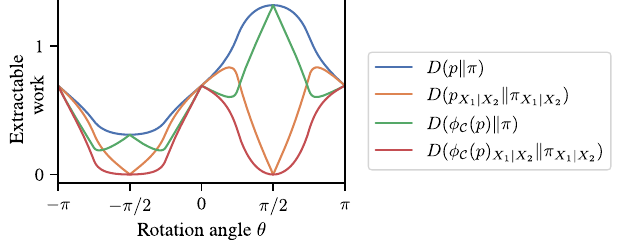
FIG. 14. Szilard box with gravity: bounds on extractable work as a function of θ , as derived from the second law [in blue, Eq. (98)], coarse-grained constraints [in orange, Eq. (99)], modularity constraints [in green, Eq. (101)], and a combination of modularity+coarse-grained constraints [in red, Eq.